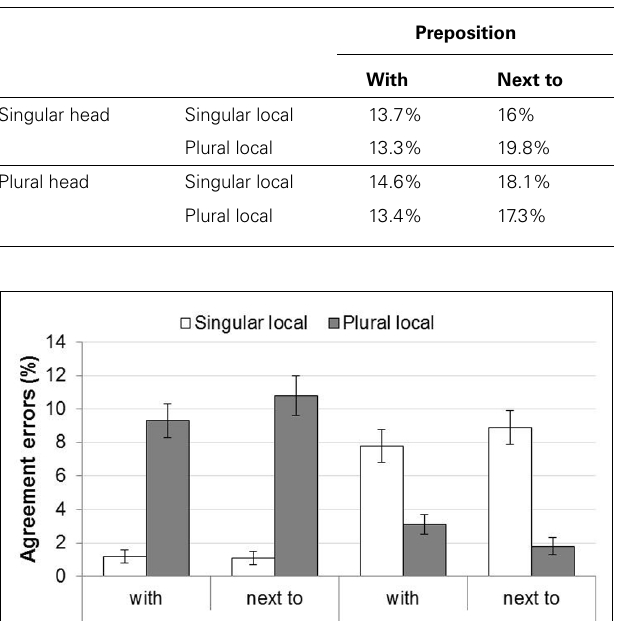
than for singular heads ( M = 5.5%, SD = 22.5%) 2 , whereas the main effect of Mismatch indicated that more errors were made when the head and local noun number mismatched ( M = 9.2%, SD = 28.9%) than when they matched ( M = 1.8%, SD = 13.2%). Over the course of the experiment, participants made fewer errors, indicated by the main effect of Block. Importantly, there was